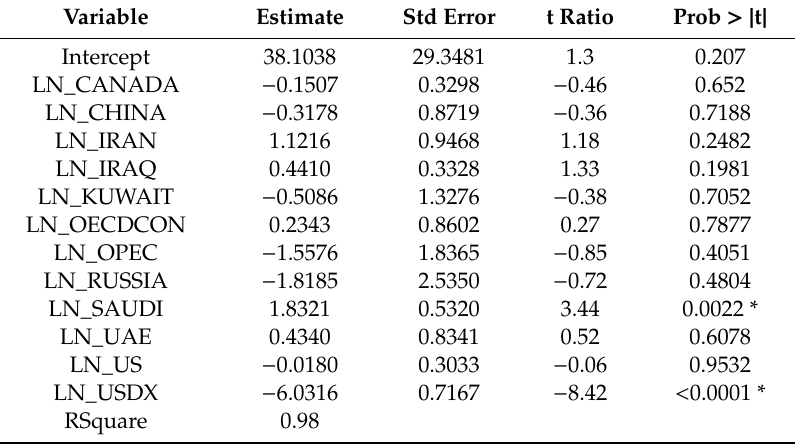
Table 16. Panel 6 period (2013–2015): LN_BRENT prediction-parameter